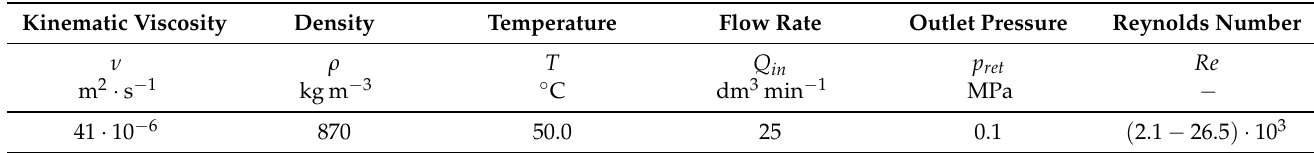
Table 1. Physical model parameters.